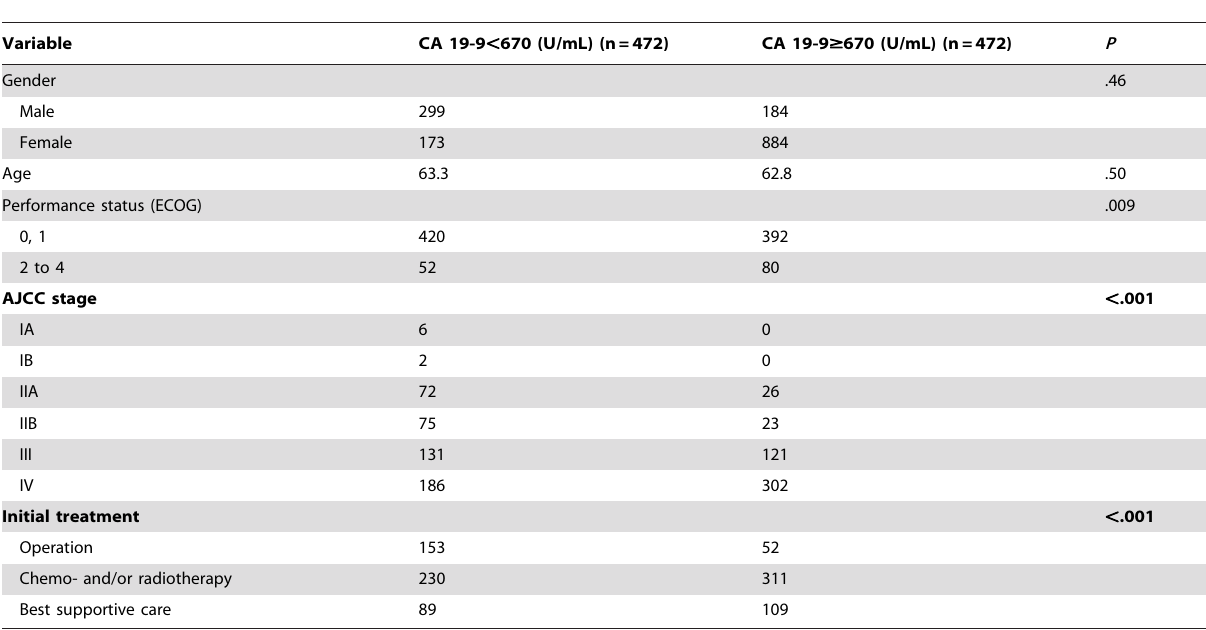
Table 1. Baseline demographics and clinical